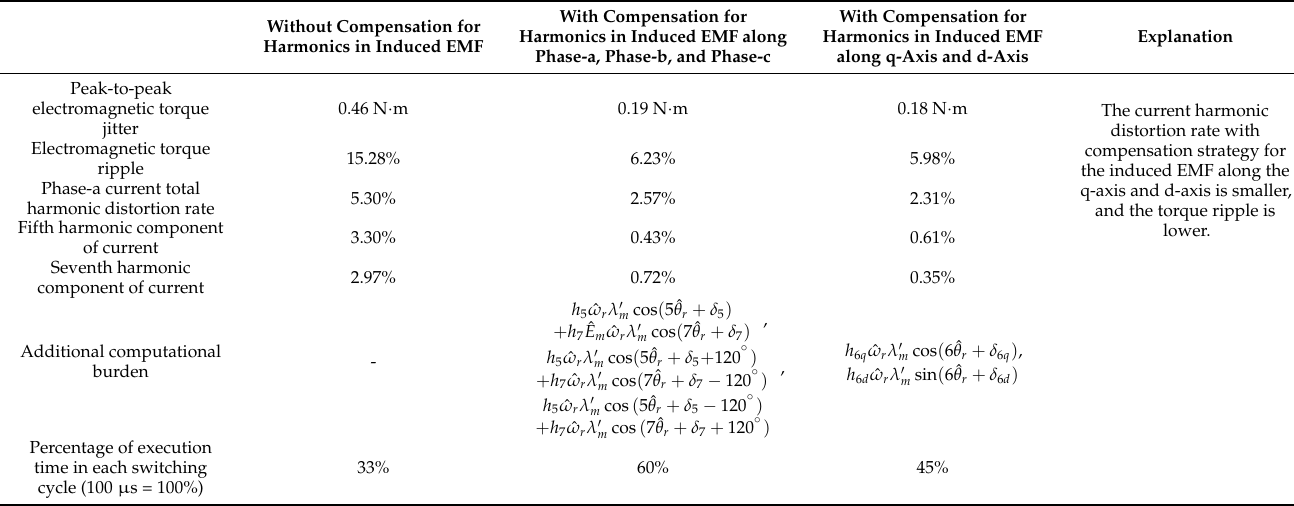
Table 1. Comparison of the closed-loop control strategy for three-phase permanent-magnet synchronous motor speed and q-axis/d-axis currents.